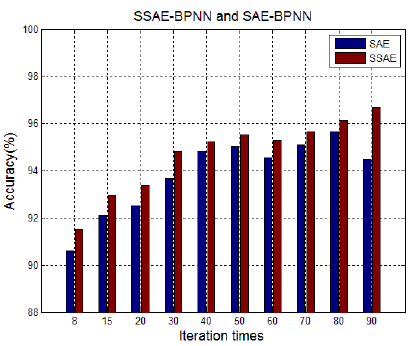
Figure 13. Comparison of SSAE-BPNN and SAE-BPNN.